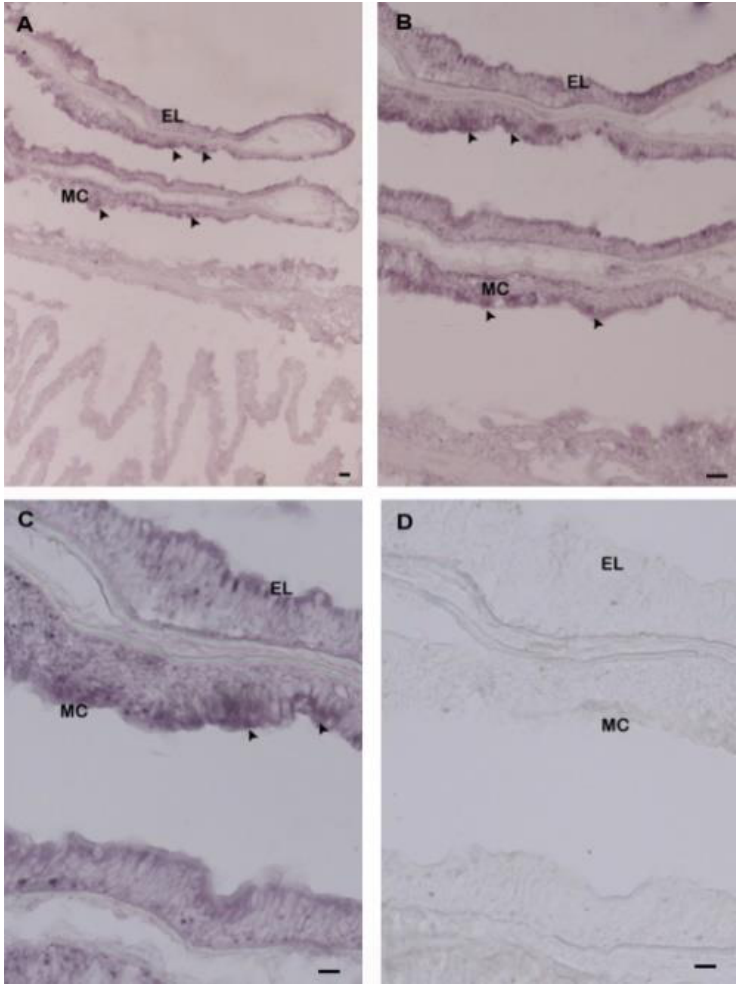
Figure 9. Hdh IGFBP7 mRNA detection in the gill of H. discus hannai by in situ hybridization. ( A ) Strong expression of Hdh IGFBP7 with an antisense probe was evident in mucus cells of the branchial epithelium, ( B ) Medium magnification of A; ( C ) High magnification showing hybridized Hdh IGFBP7 mRNA in mucus cells. ( D ) No hybridization signal was seen in the control section stained with a sense probe. Hybridization signals are indicated with black arrowheads. Scale bar, 100 µ m. EL, epithelial layer; MC, mucus cells.